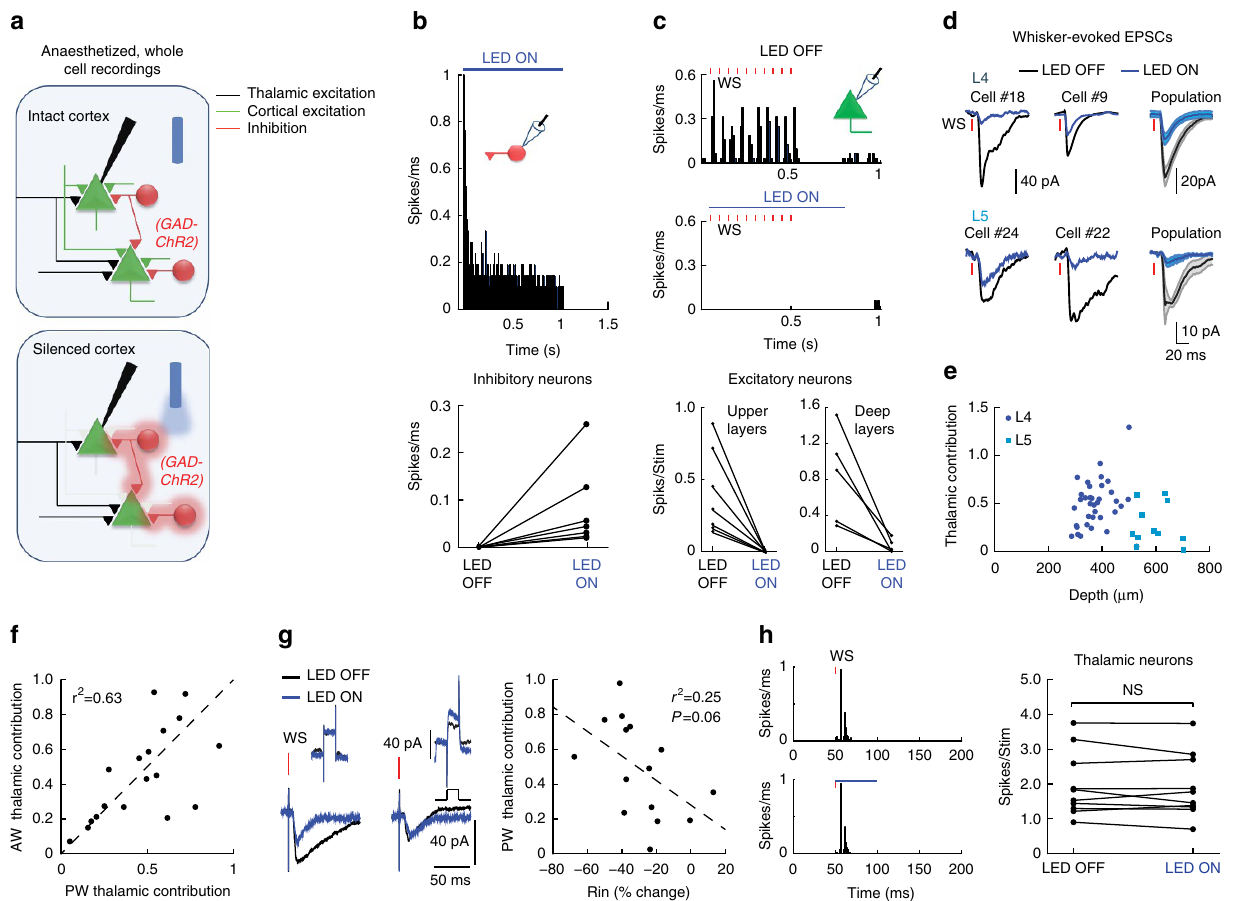
Figure 1 | Optogenetic isolation of thalamic excitatory inputs to cortical neurons. ( a ) Schematic illustration of cortical silencing experiments in anaesthetized mice. Light activates ChR2 expressing inhibitory cells, which in turn silence the firing of cortical cells. ( b ) Peri-stimulus spike time histogram (PSTH) for an example GAD þ -ChR2 cell in response to 1s LED illumination (top) and population mean firing rate of GAD/PV þ -ChR2 cells (bottom). ( c ) PSTH of a putative excitatory L4 cell in response to repetitive whisker stimulation (red bars) in LED OFF and LED ON conditions (top) and population average spike count per stimulus of cells located in upper layers (bottom left) and deep layers (700–1,100 m M, bottom right). ( d ) Average whisker-evoked excitatory currents in two example L4 (left, top panel) and L5 (left, bottom panel) cells recorded independently during LED OFF and LED ON conditions and the population average currents (right). ( e ) Population depth profile of the thalamic contribution to evoked excitatory response of all recorded neurons ( n ¼ 47). ( f ) The contribution of thalamic input for each cell, when the principal whisker (PW) or adjacent whisker (AW) was stimulated. ( g ) Average EPSC in response to 10mV step (left, top panel) and whisker deflection in two recorded cells during LED OFF and LED ON (left, bottom panel) conditions. Right panel shows population thalamic contribution versus change in input resistance. ( h ) PSTH of a ventral posteromedial nucleus (VPM) neuron in response to whisker stimulation during LED OFF (left, top panel) and LED ON (left, bottom panel) condition. Right panel shows the population average spike count per stimulus of VPM